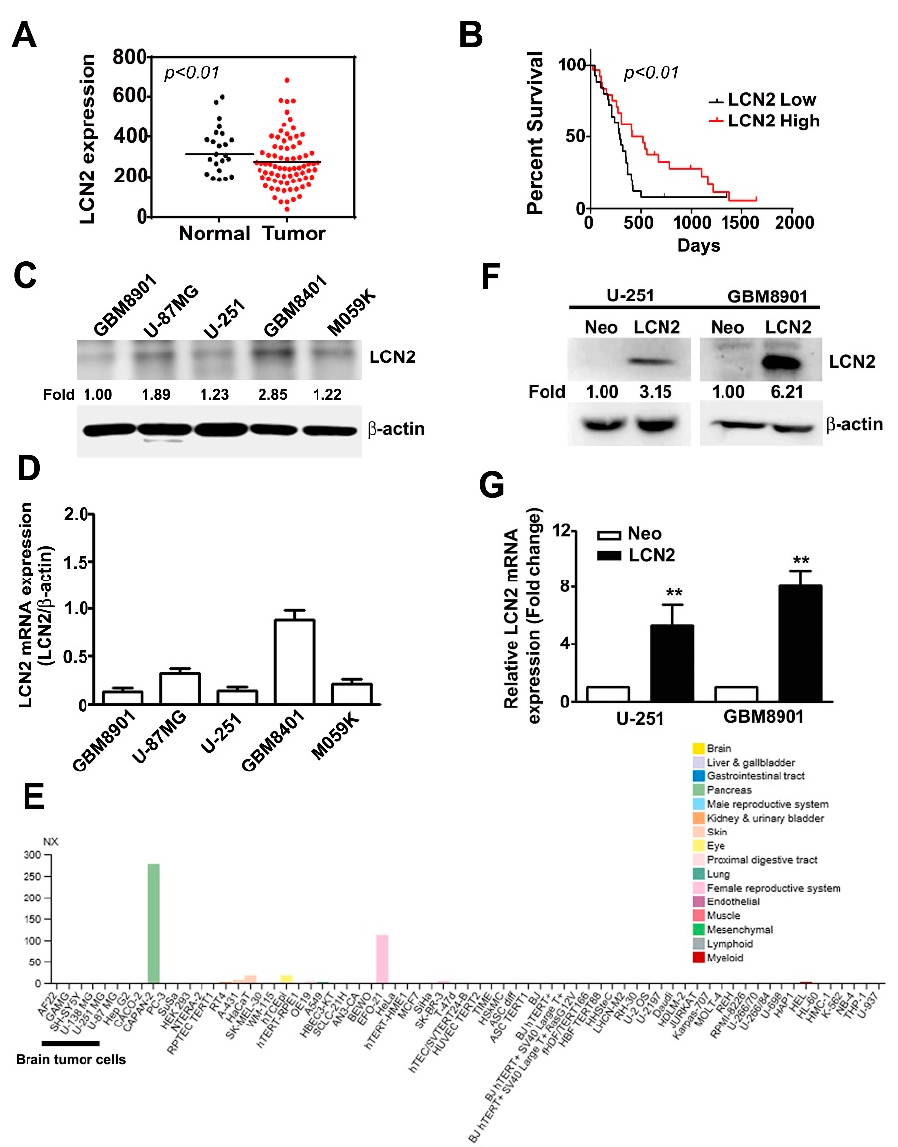
Figure 1. LCN2 expression in GBM tissue, glioma cell lines, and LCN2-transfected GBM cells ( A ) LCN2 expression in GBM and normal tissues and ( B ) survival analysis of data in the GSE4290 and GSE13041 database. Endogenous LCN2 expression in human GBM cell lines (GBM8901, U-87MG, U-251, GBM8401 and M059K) was analyzed by western blot ( C ) and RT-qPCR ( D ). ( E ) The LCN2 mRNA expression level in human GBM cells (GAMG, SH-SY5Y, U-138 MG and U-87MG) from the Human Protein Atlas project database. LCN2 protein and mRNA levels in LCN2-overexpressed or Neo-GBM8901 and U-251 cells as detected by western blot ( F ) and RT-qPCR ( G ). β -actin, protein loading internal control; GAPDH, mRNA control. Data are presented as the mean ± SE of at least three independent experiments. ** p < 0.01 compared to Neo cells.